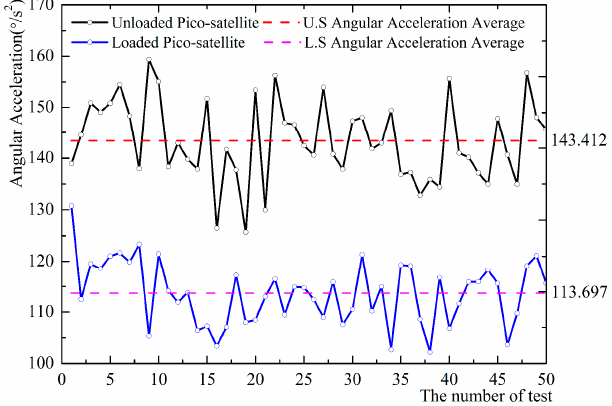
Figure 11. Angular acceleration in different states at a vertical position.